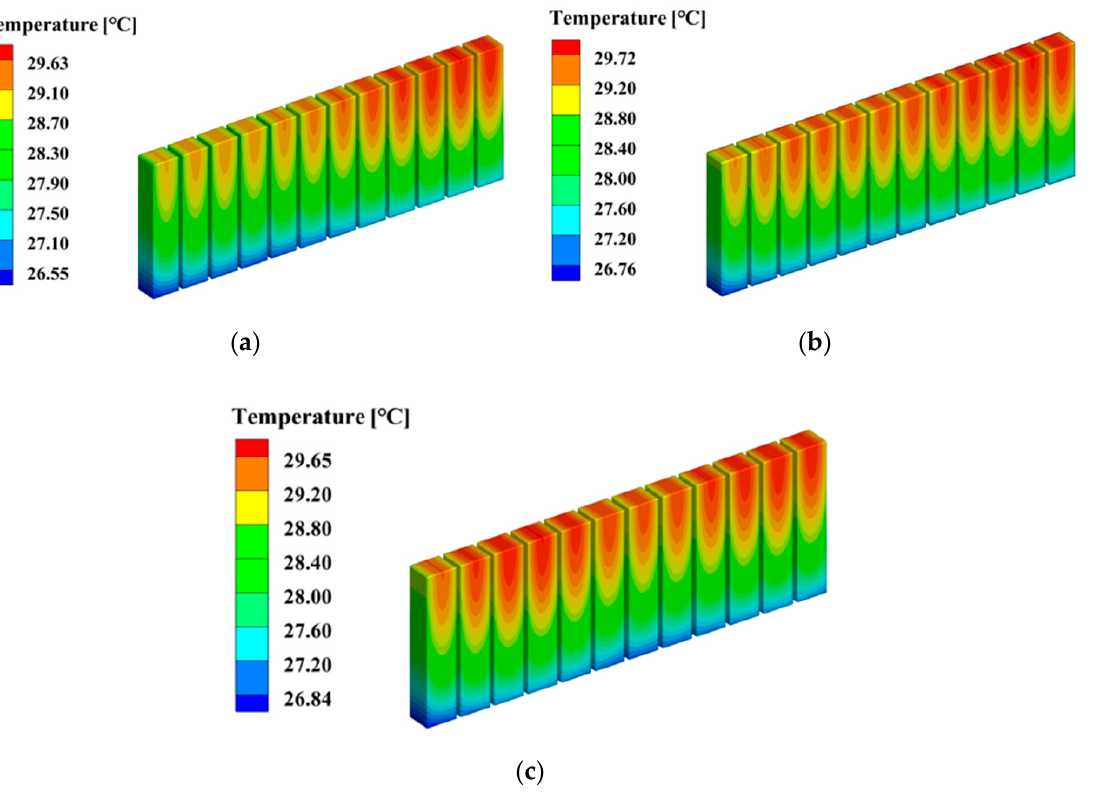
Figure 9. Temperature distribution of battery module: ( a ) d = 31 mm; ( b ) d = 46 mm; ( c ) d = 61 mm.